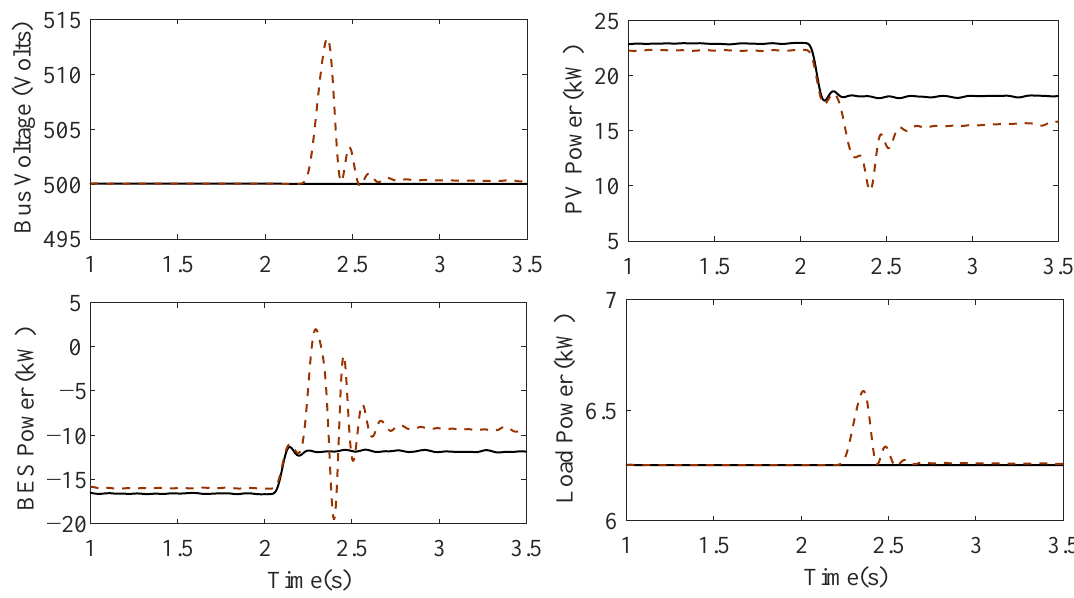
Figure 6. Bus voltage and different power responses under generation change. Table 2. Quantitative comparison between proposed and existing controller under generation